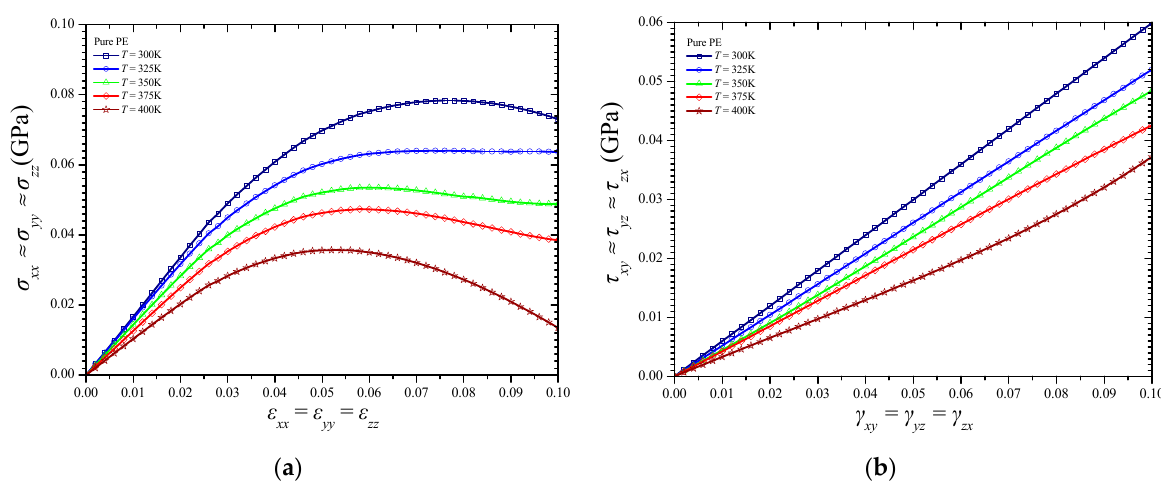
Figure 7. Stress–strain curves in ( a ) tension and (b ) shear of the pure PE for various temperatures. On the other hand, the computations showed that the NC materials present a distinct behavior along the longitudinal, i.e., effective, direction x in which the NFB is oriented, while they demonstrate an almost identical tensional response along the two transverse directions y and z because of the transverse cross-sectional symmetry of both NFBs. The tensile stress–strain temperature-dependent response of the BS and the OC SWCNT reinforced PE along the longitudinal x -axis and transverse y - or z -axis is illustrated in Figure 8a,b, respectively. In addition, Figure 9 depicts the variation of the zx shear stress versus the zx shear strain and temperature.